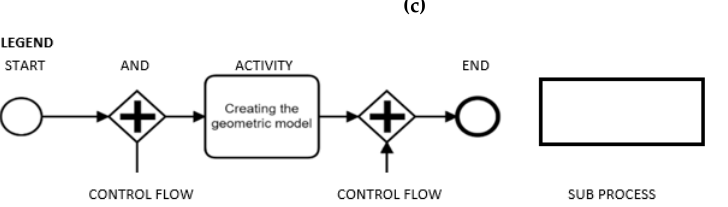
Figure 6. ( a ). Sequence of steps for domain-specific DT development model in PLM for subprocess ‘Creation of a virtual product representation’. ( b ). Sequence of steps for domain-specific DT devel- opment model in PLM for subprocess 2 (Analysis, integration and visualization of data), ( c ) further processing. Data of variant 1 as described in [9], data of variant 2 as described in [8].